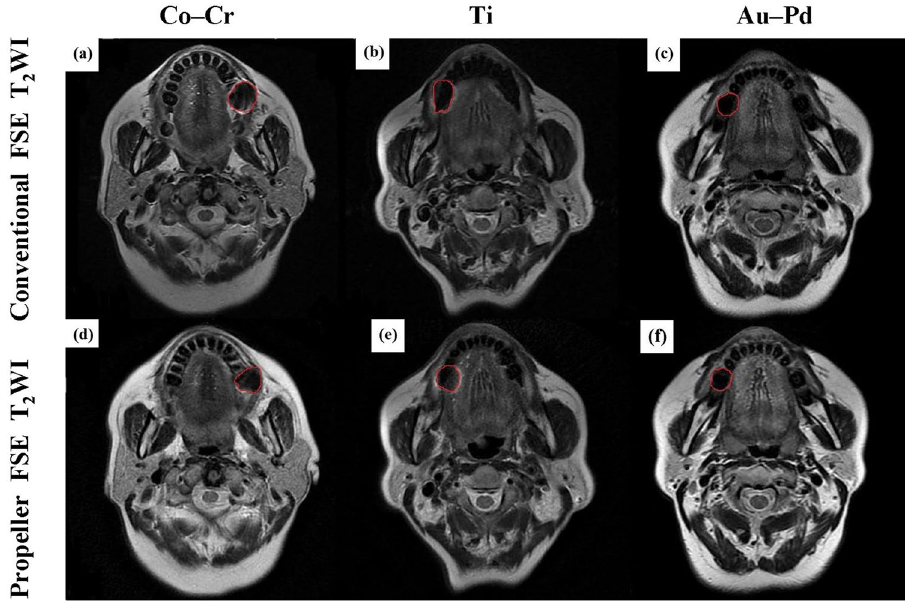
Figure 1. Images of conventional FSE T 2 WI ( a – c ) and PROPELLER FSE T 2 WI ( d – f ) in different participants. Images of the metal crown of Co-Cr alloy in participant 1 ( a , d ); Images of the metal crown of pure Ti in participant 2 ( b , e ); Images of the metal crown of Au–Pd alloy in participant 3 ( c , f ).